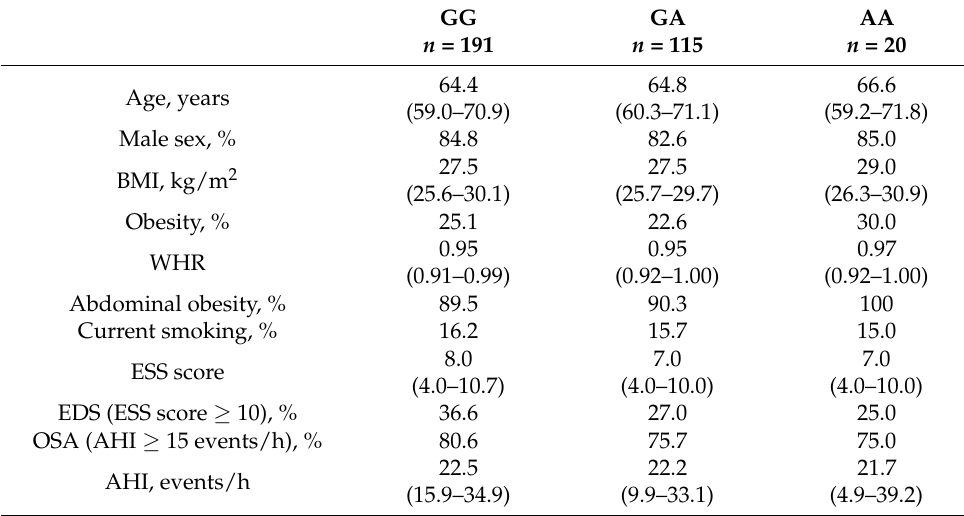
Table 2. Baseline demographic and clinical characteristics of the study